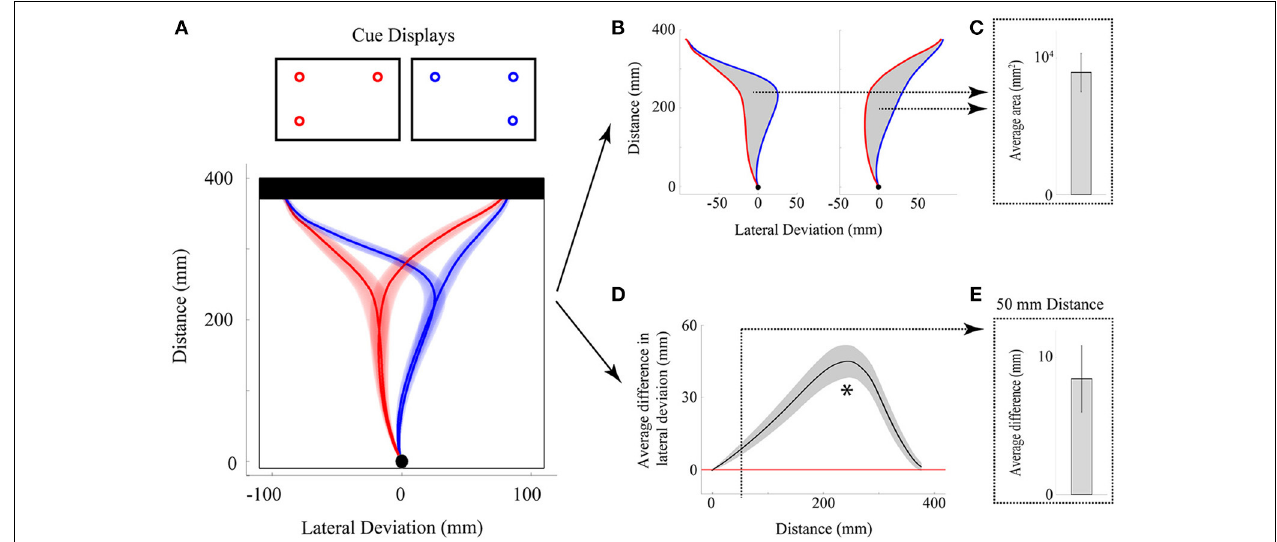
FIGURE 5 | Illustration of experiment results using non-functional measures. (A) Overhead view of the group-averaged reach trajectories toward mirror displays [2v1(high) in red; 1(high)v2 in blue] for cases in which the top left or top right target positions were cued. Note that the direction of the initial movement trajectory is independent of which target position (top left or top right) is actually cued at movement onset. (B,C) Analysis of the average area between trajectory traces. The area between reach trajectories [gray shading in (B) ] is computed for each reach endpoint position [top left or top right, (B) ], averaged across endpoints and then individuals, and then plotted in bar graph form [in (C) ]. Statistical significance is assessed by comparing the group-averaged area values to zero. Error bar shows the 95% confidence interval and, when above zero, denotes that the average areas between trajectories differed significantly ( p < 0 . 05). (D,E) Analysis of the